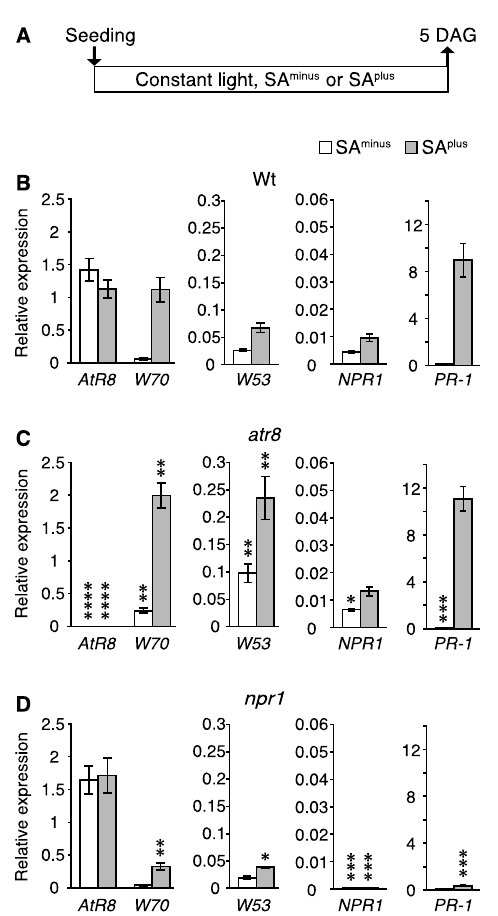
Figure 8. RNA accumulation levels in Arabidopsis plants including npr1 at an early developmental stage. ( A ) Timeline of experimental procedure. The total RNAs were extracted from the seedlings of Wt, atr8, and npr1 , which were grown on 0.24% gellan gum media SA plus or SA minus (20 µM SA), and subjected to RT-qPCR with ACT2 and ACT8 genes as standards. Bar graphs represent the mean values of three independent assays ( ≥ 100 plants), and error bars represent ± SE. W53 : WRKY53 , W70 : WRKY70 . ( B ) Wt, ( C ) atr8 ( AtR8 null mutant), and ( D ) npr1 ( NPR1 hypomutant). Significant differences in RNA accumulation levels between Wt ( B ) and each of the mutants ( C – D ) are indicated as * p < 0.05, ** p < 0.01, *** p < 0.001, and **** p < 0.0001 (Welch ’ s t -test).